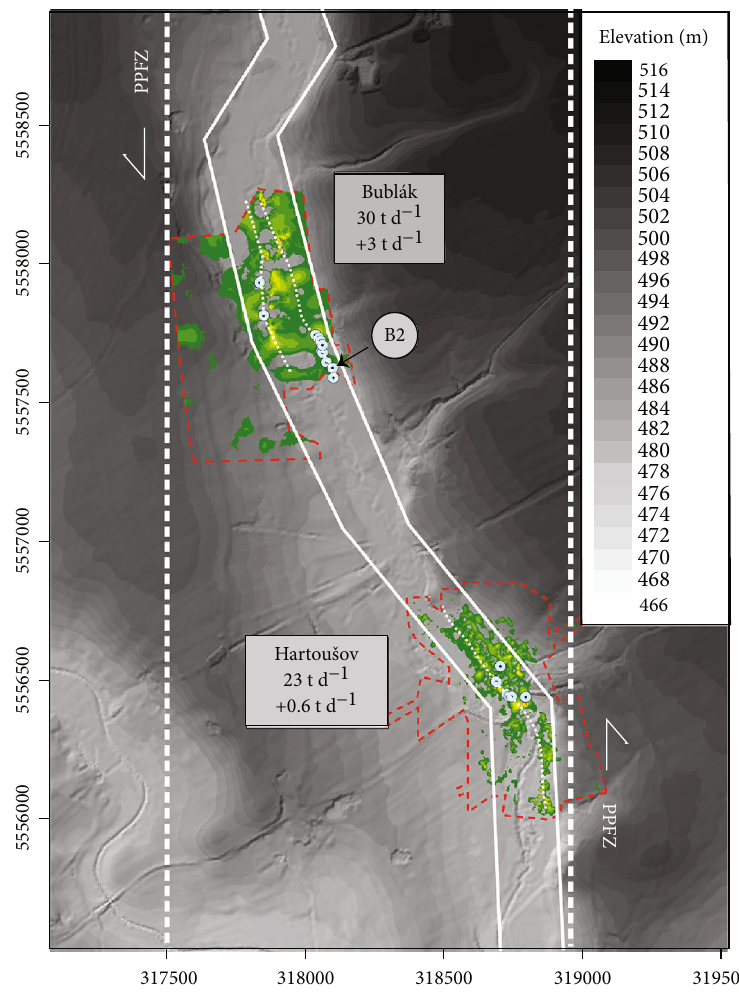
Figure 9: Structural setting of the Hartou š ov and Bublák mofette fi elds with the locations of DDS and wet mofettes (blue